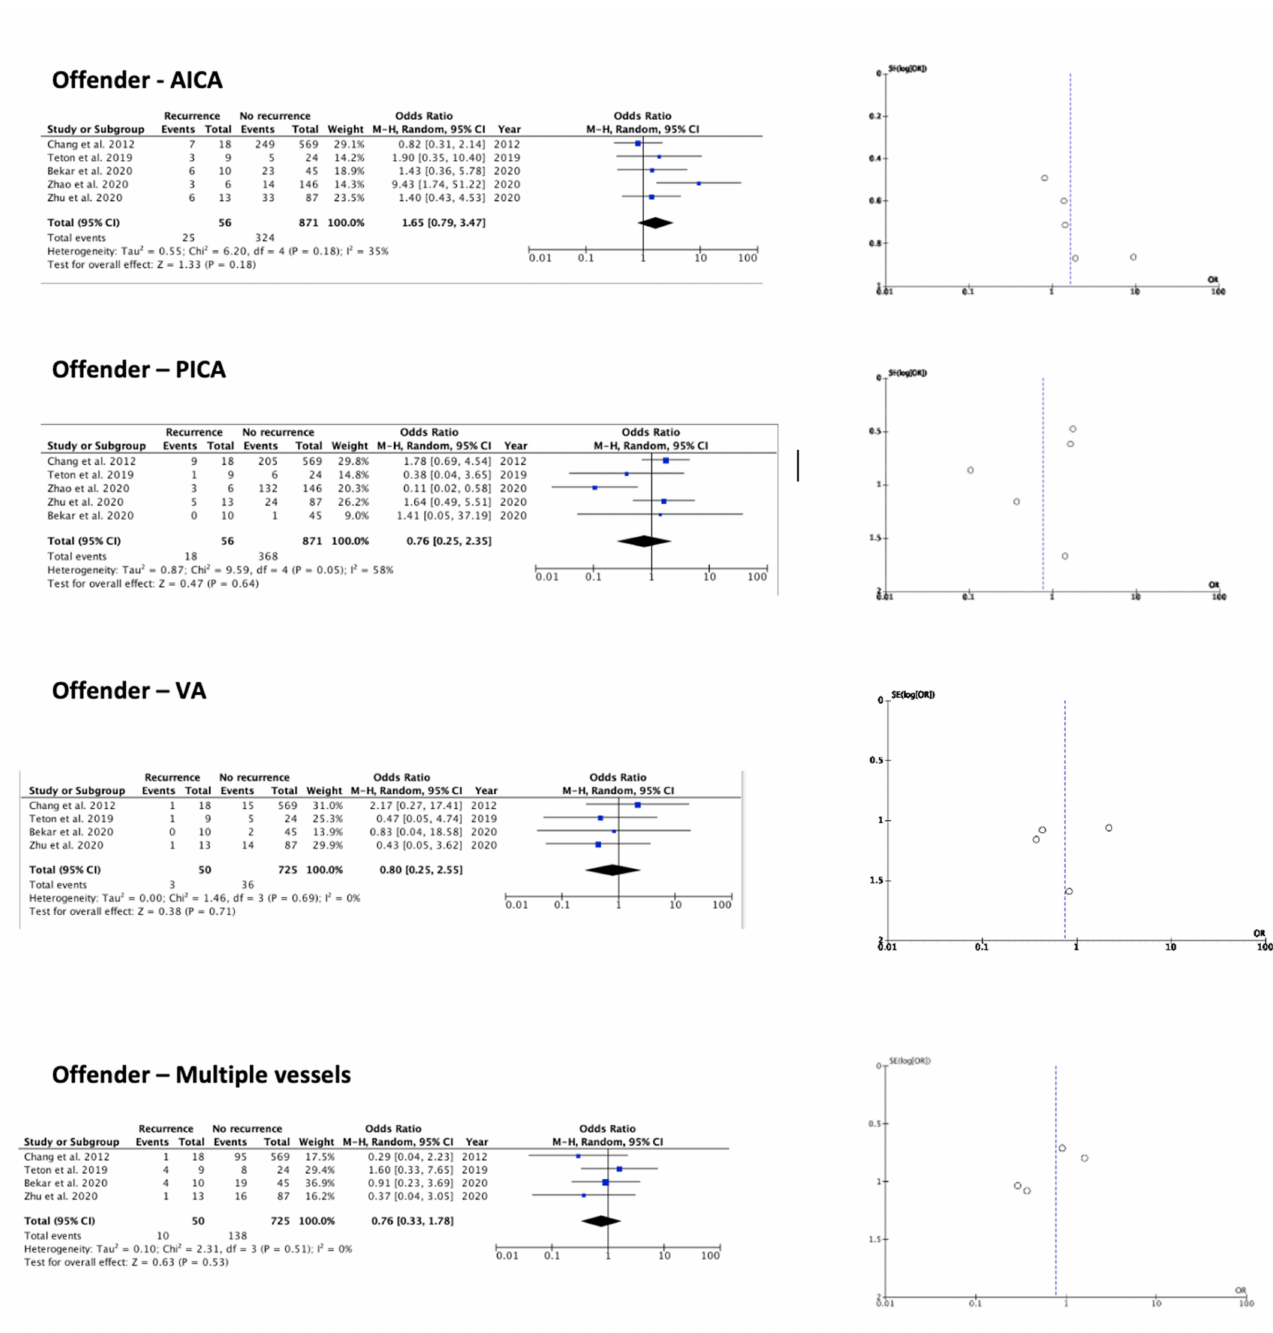
Figure 3. Forest plots and funnel plots for investigated radiological variables